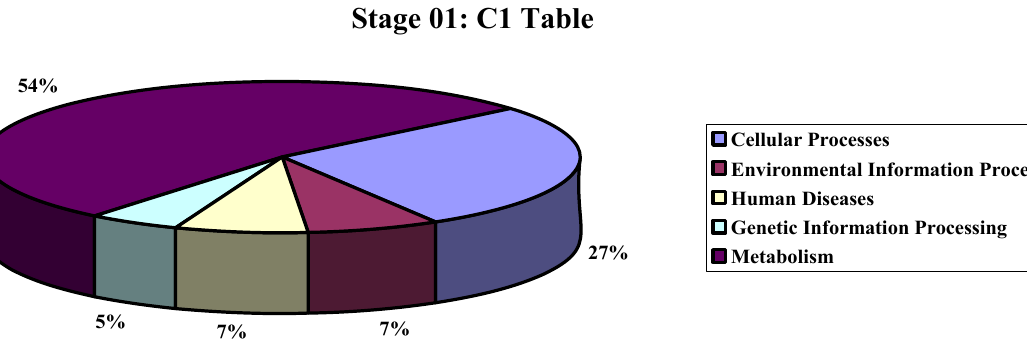
Figure 1. KEGG pathway analysis of the differentially expressed genes at stage